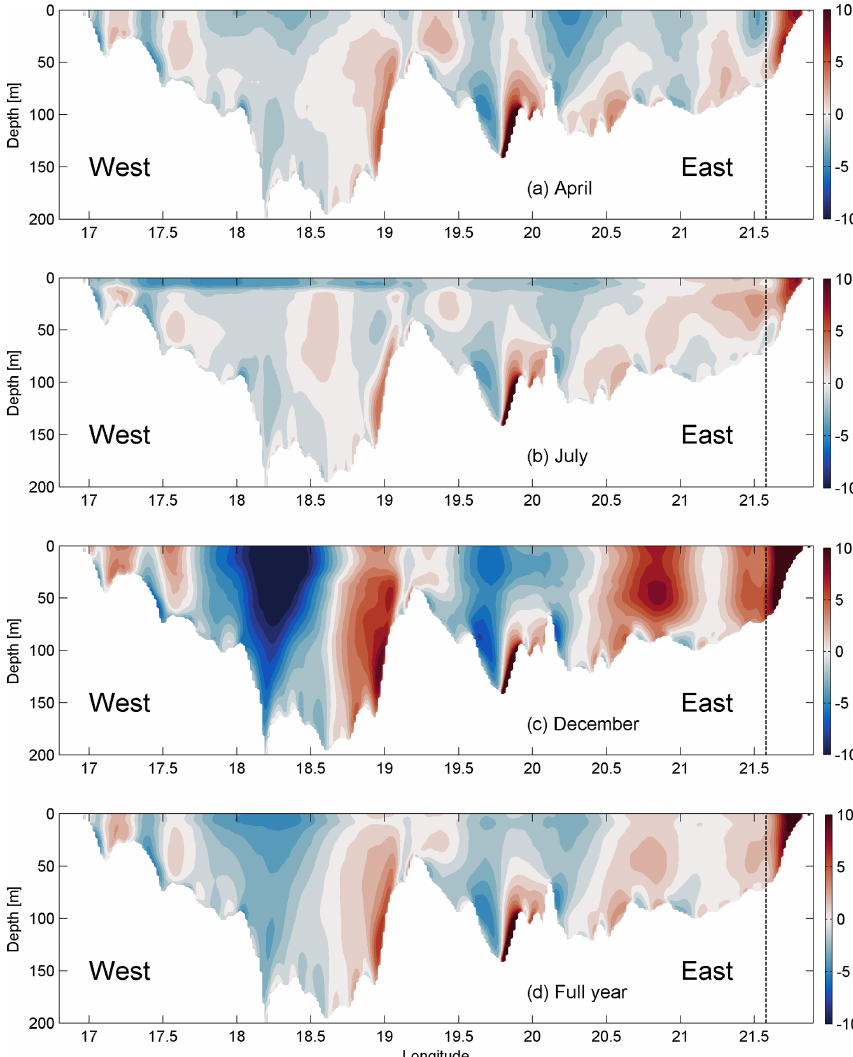
Figure 12. Vertical distribution of monthly mean (April, July, and December) and annual mean meridional velocities (positive northward) along the zonal section at ADCP latitude based on simulation data from September 2010 to August 2020. The color scale shows meridional velocity in centimeters per second (cms − 1 ). Vertical dotted lines show the ADCP